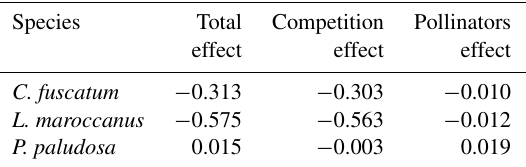
Table 2. The direct effects (standardized total effects) of plant com- petition and the indirect effects mediated by pollinators on the plant reproductive success at the 7.5cm radius scale (see Table A5, Ap- pendix A, for the effects on each scale). We have chosen this scale because it is the scale most representative of plant